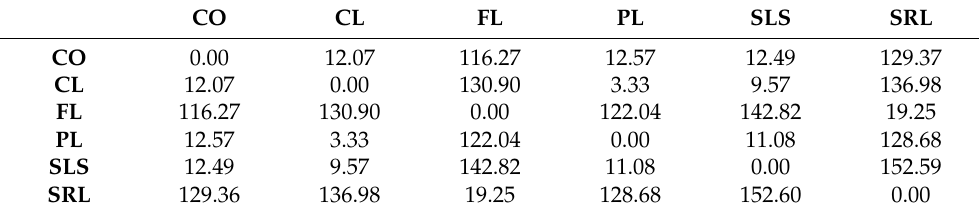
Table 5. Squared Mahalanobis distances (SMD) between the investigated lithological groups